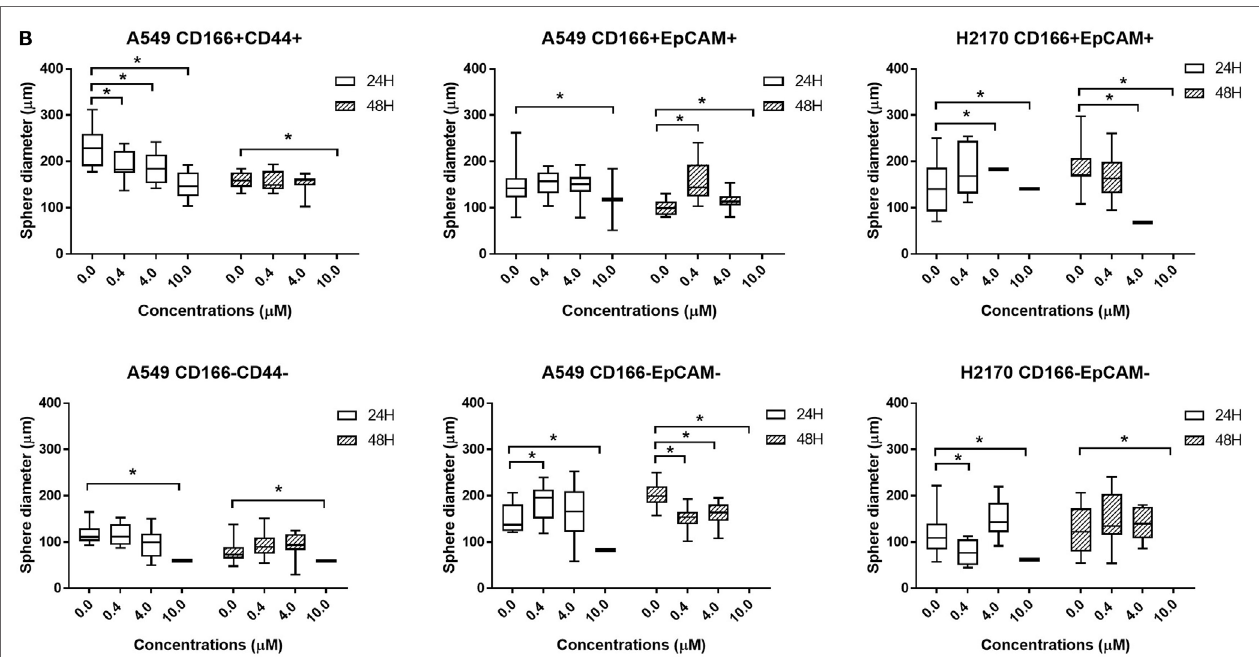
FigUre 4 | Effect of BMS-345541 on the sphere-forming capacity of lung cancer stem cells (CSCs). The cells were induced to form sphere following treatment with different concentrations of BMS-345541 for 24 and 48 h. (a) The images of the spheres formed following the treatments with BMS-345441 for lung CSCs and non-CSC counterparts. (B) Boxplots illustrate the sphere diameter ( μ m) for each cell type following the treatments. Data shown are representative of three independent experiments ( n = 3). The y -axes show the sphere diameter ( μ m) and the x -axes show the concentration of BMS-345441 (0, 0.4, 4.0, and 10.0 µM) used in the treatment. Upper and lower boxplot margins represent the interquartile range, and the middle bar indicates the median. The whisker defines the range of values. The diameter of the spheres was measured using ImageJ analysis software. The bar above the boxes represents statistically significant differences *p < 0.05; two-way analysis of